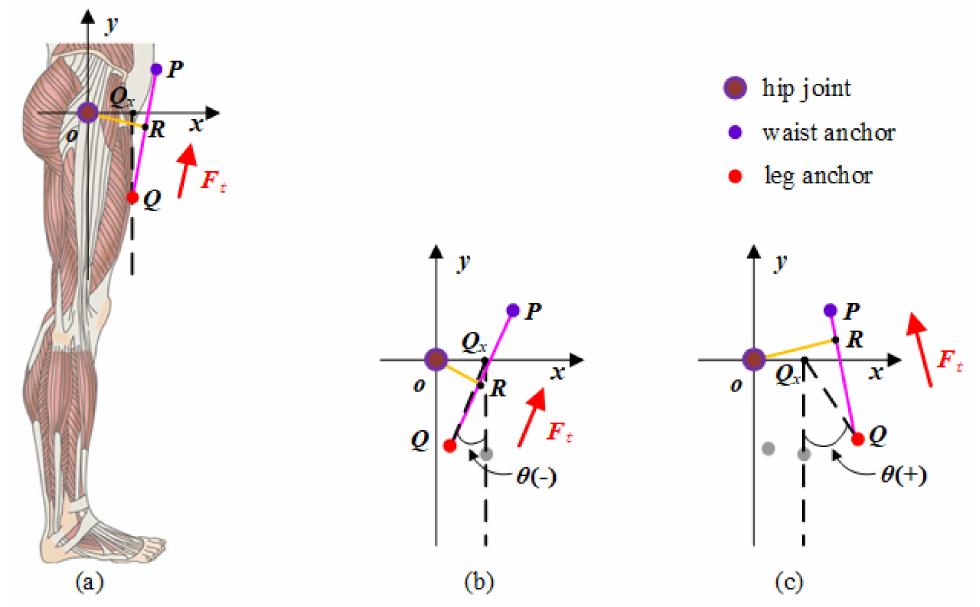
Figure A1. Simplified model of human lower limbs. ( a ) Standing phase ( θ = 0). ( b ) Stretching stage ( θ < 0). ( c ) Buckling stage ( θ >